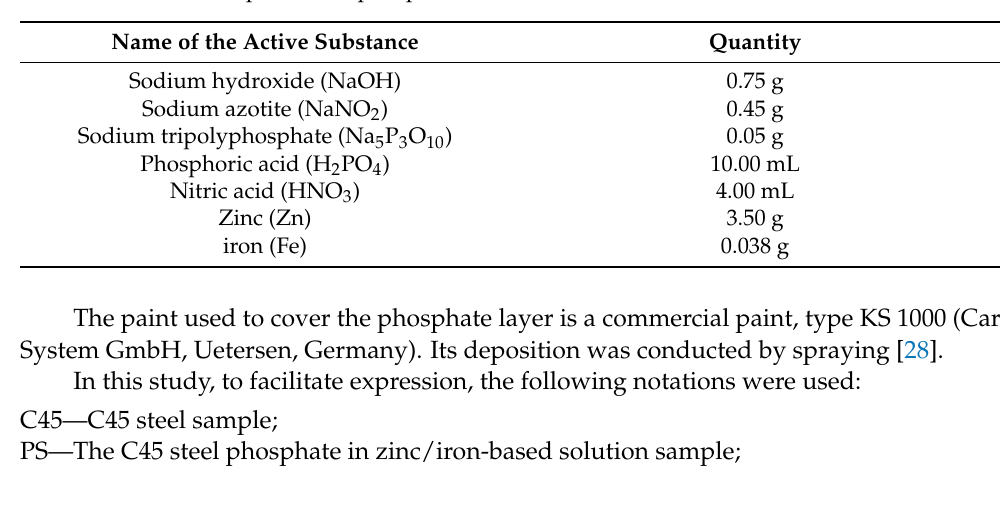
Table 2. Chemical composition of phosphate